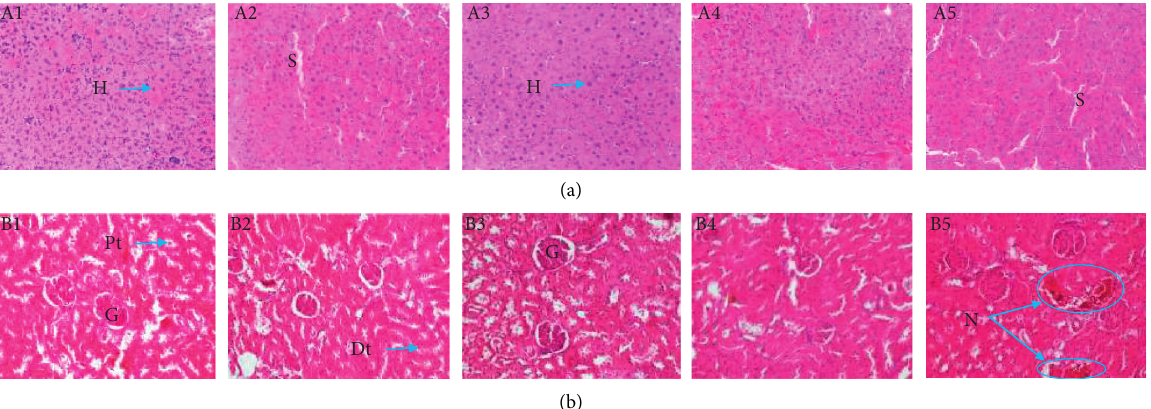
Figure 5: Effects of aqueous extract of T. grandis leaves on histological features of the liver (a) and kidney (b) in male rats (H&E × 400). A1, B1: control; A2, B2: 30mg/kg; A3, B3: 90mg/kg; A4, B4: 270mg/kg; A5, B5: 810mg/kg. G: glomerulus; N: necrosis; S: sinusoids; H: hepatocytes; Pt: proximal tube; Dt: distal tube. The liver and kidney photomicrographs presented in the document represent the general appearance observed in at least three of the four animals in each